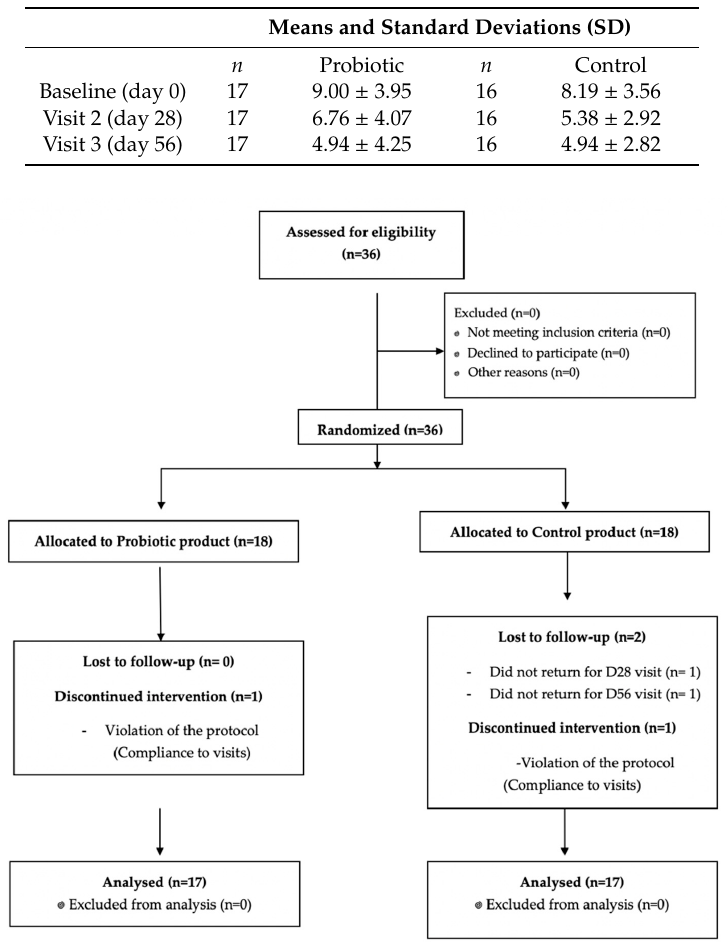
Table A3. Local SCORing Atopic Dermatitis (SCORAD) of the subjects after continuous use of the probiotic or control product at baseline, visit 2 (day 28) and visit 3 (day 56). Standard deviation (SD).